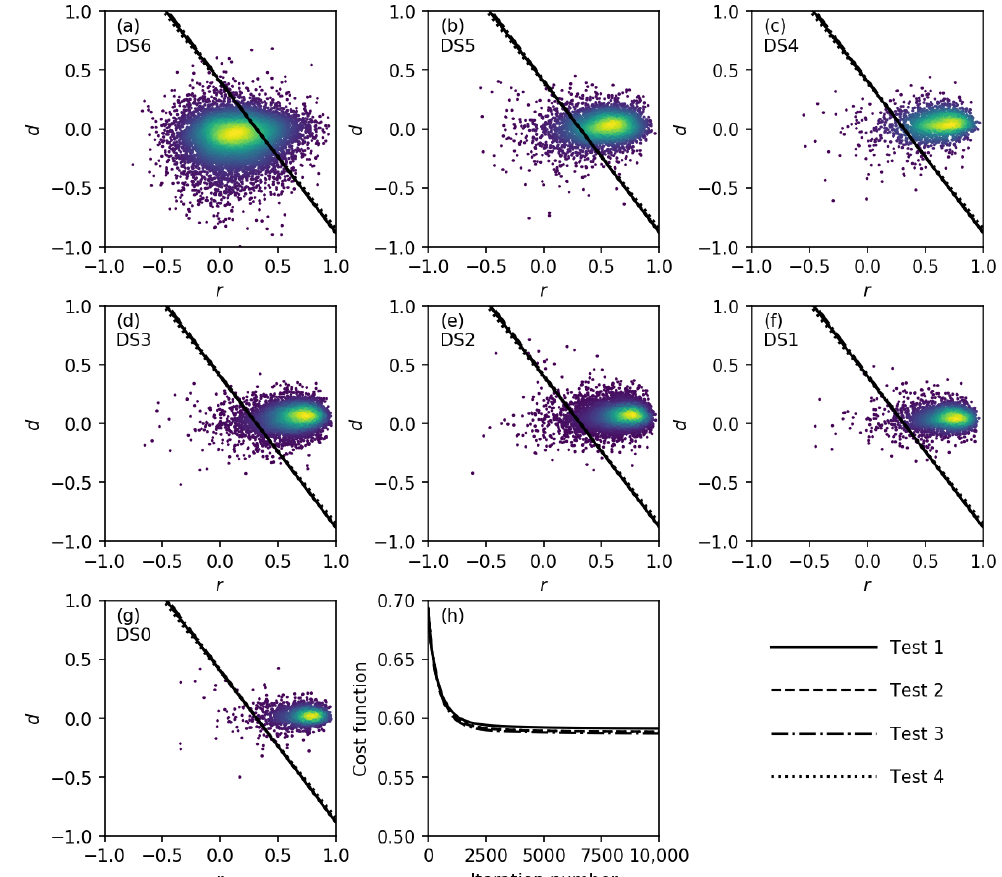
Figure 5. Discriminant functions obtained using the fragility function of Suppasri et al. [28]. ( a – g ) Scatter plots of the bi-dimensional dataset separated by DS, together with the obtained discriminant functions; ( h ) Variations of the cost function ( J ( θθθ ) ) throughout the iterative gradient descent